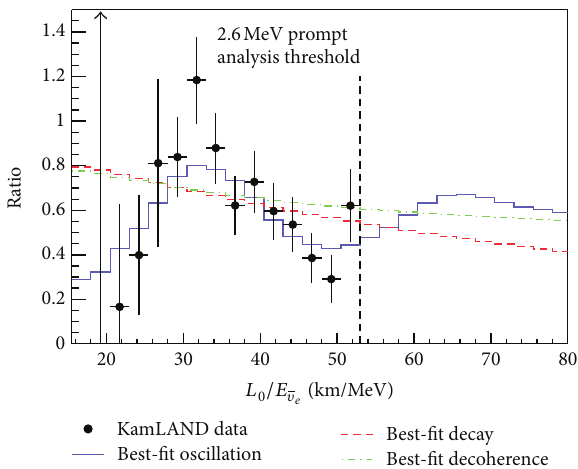
Figure 3: Ratio of the observed 𝜈 𝑒 spectrum to the expectation for nooscillation versus 𝐿 0 /𝐸 . The curves show the expectation for the best-fit oscillation, best-fit decay, and best-fit decoherence models, taking into account the individual time-dependent flux variations of all reactors and detector effects. Taken from [39].